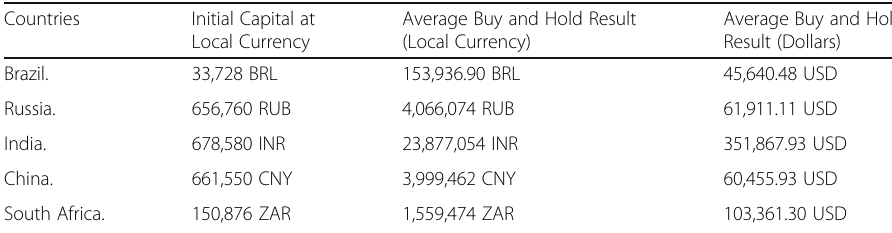
Countries Initial Capital at